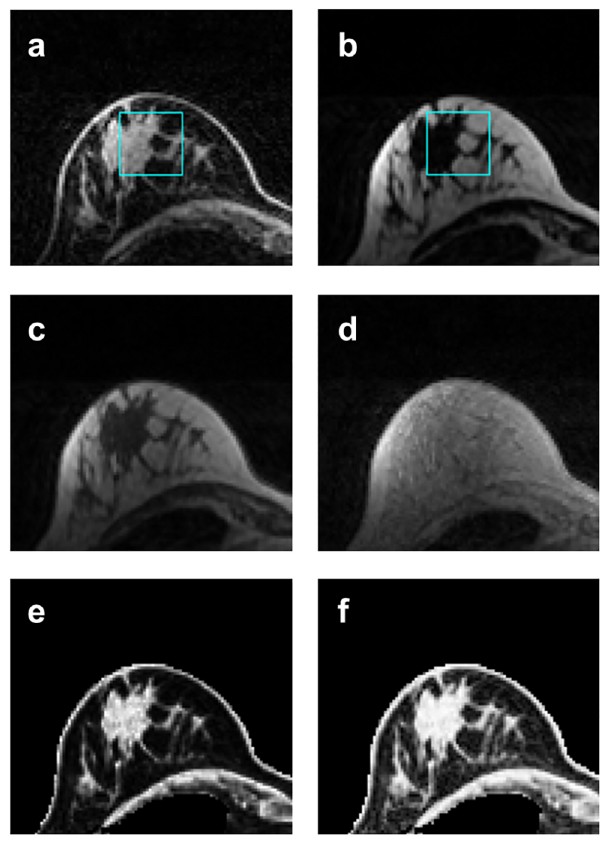
Fig 1. High resolution GRE T 1 -weighted Dixon breast images of the right breast in a 31 year old volunteer, showing the effect of signal intensity correction. A signal intensity correction factor was derived from the maximum water and fat signal intensities within a centrally located region of interest (ROI) on the Water- and Fat-only images ( a and b , respectively, each scaled to their maximum signal intensity) and was applied to the Water-only image. The |Water + Fat| and Water Fraction images prior to signal intensity correction are shown in c and e , respectively. The equivalent images following signal intensity correction are displayed in d and f , respectively; d shows clearly the normalized contributions of water and fat following correction of the Water-only image. Calculated %FGT was found to be